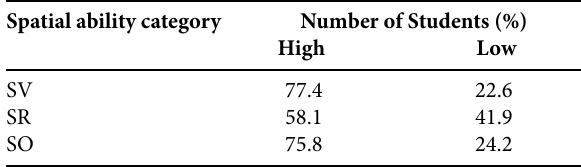
Table 1. Students’ Spatial Ability Test Results